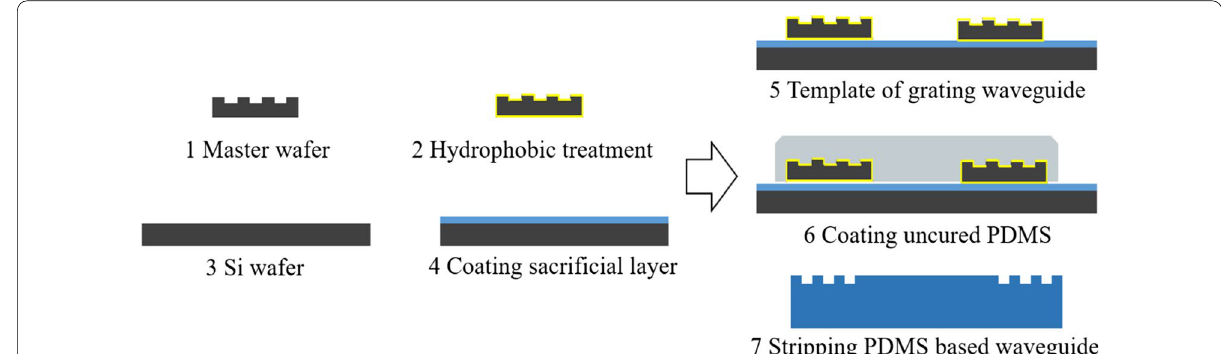
Fig. 4 Nanoreplica molding fabrication process of the flexible and stretchable optical waveguide